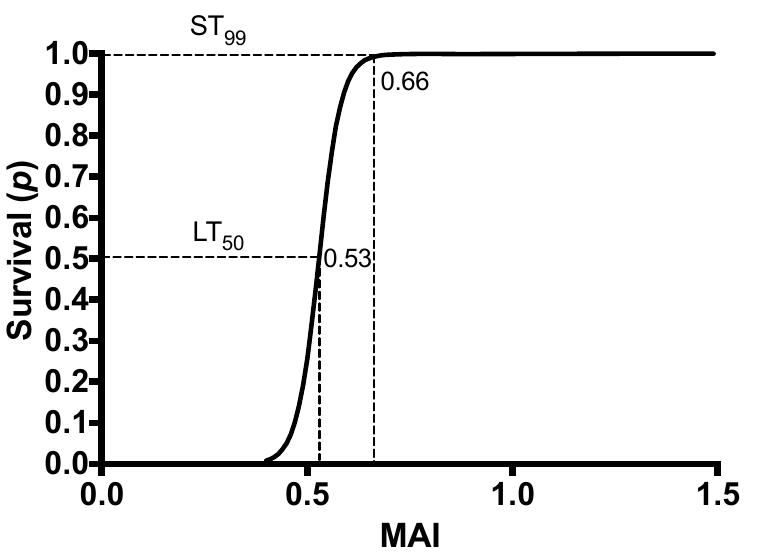
Figure 1. Logistic regression of the methaemoglobinaemia absorbance index (MAI) and survival probability ( p ) that defined the ST 99 and LT 50 thresholds based on the lowest values at T1 and T2 measured in 35 birds (duck = 7, chicken = 7, quail = 9, pukeko = 7, black-backed gull = 5).